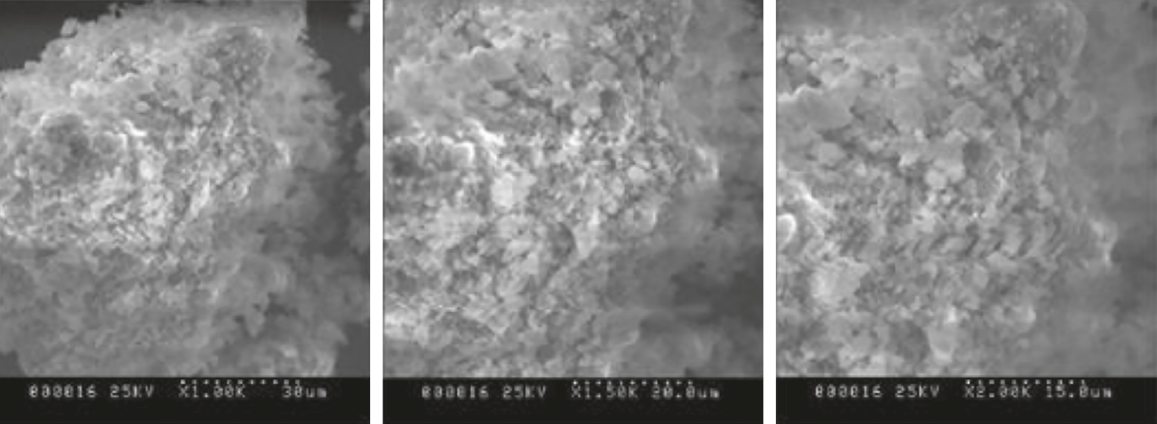
Figure 4: The result of SEM.